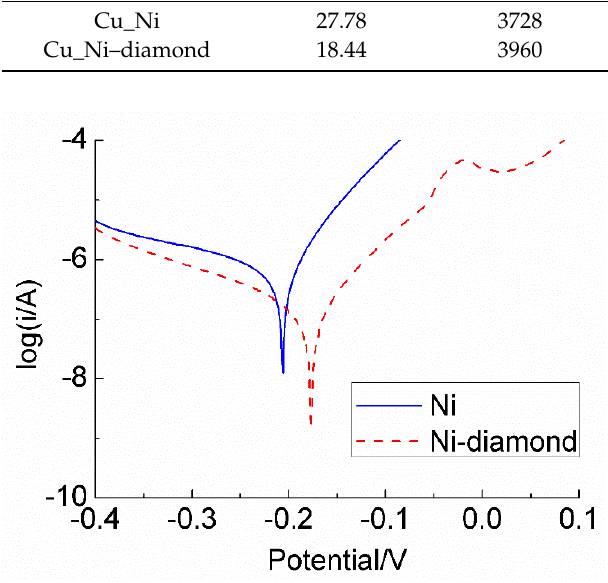
Figure 11. The Tafel curves of the Ni coating and the Ni–diamond coating.